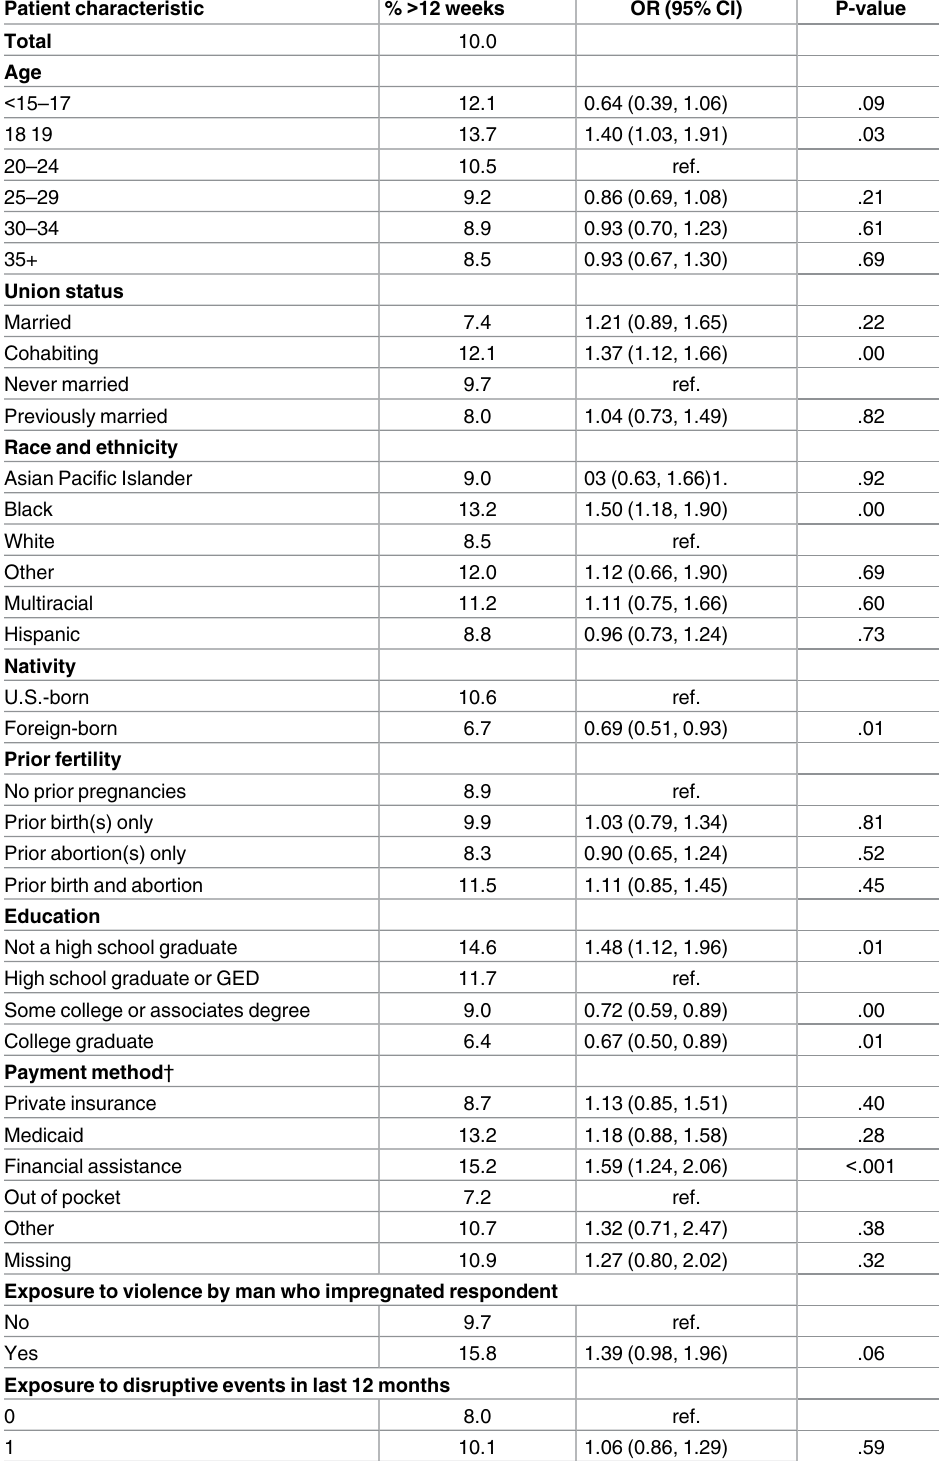
Table 3. Frequency of second-trimester abortion by patient characteristics and odds ratios from mixed-effects logistic regression models examining characteristics associated with second-trimester